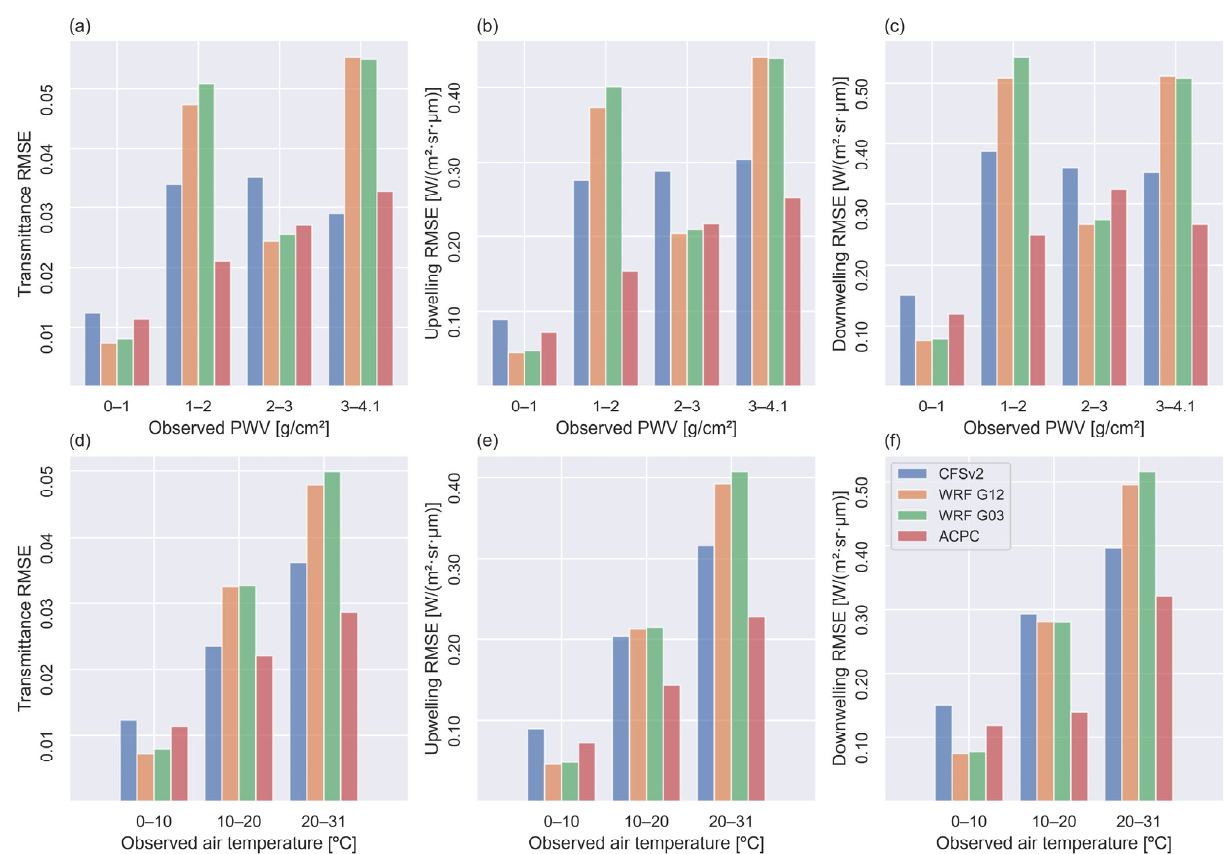
Figure 5. Atmospheric parameters’ RMSE values calculated for specific ranges of observed precipitable water vapor (PWV) ( a – c ) and air temperature ( d – f ).